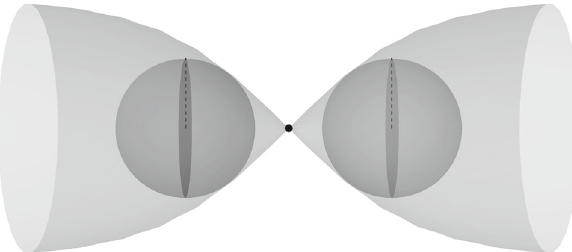
Fig. 3 This figure displays the conical singularity appearing in the t- y slice of the geometry. A spherical cap of small radius, r is put to regularize the